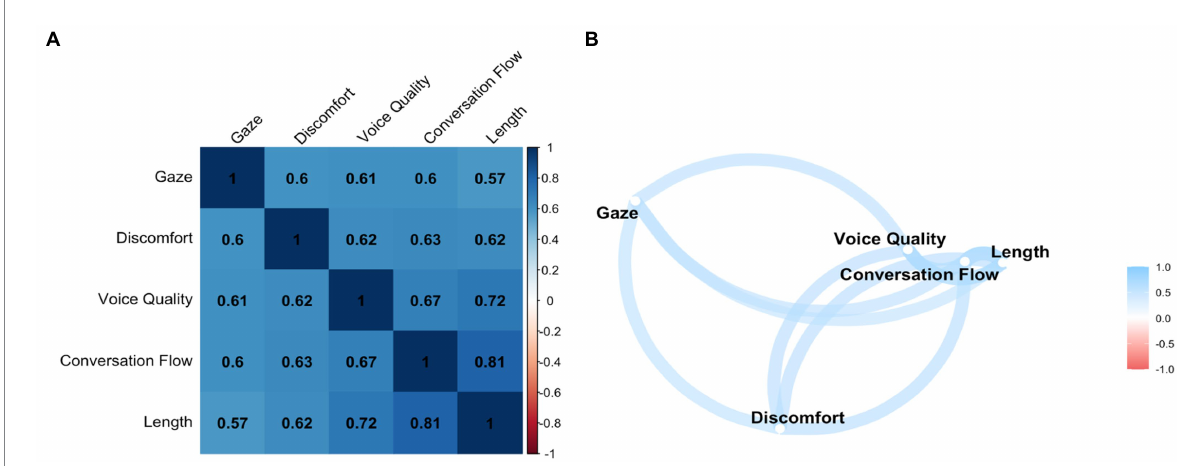
FIGURE 3 Correlation between items: (A) Spearman’s rank correlation coefficients matrix and (B) correlation network. Correlation between items: (A) matrix of Spearman’s rank correlation coefficients and (B) correlation network. The matrix contains the Spearman’s rank correlation coefficients between the 5 SPRS questionnaire items. Colors indicate the direction and strength of the correlation, with positive correlations displayed in blue and negative correlations in red. Results in bold indicate statistical significance at the p < 0.05 level. All results are statistically significant. The correlation network is constructed from all pairwise correlations between items in (A) . Items are represented by nodes and are connected by edges. The red and blue lines represent negative and positive correlations, respectively. The color saturation of the line widths is proportional to the strength of the correlation.